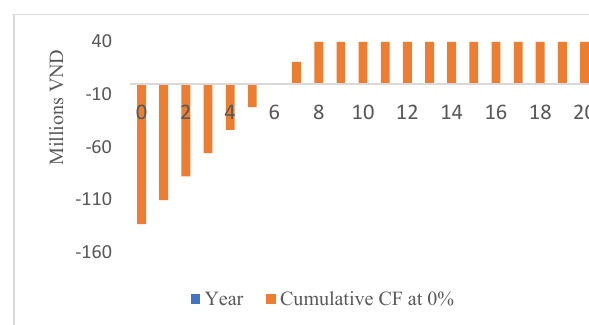
Figure 12. Cumulative Cash Flow at discount rate